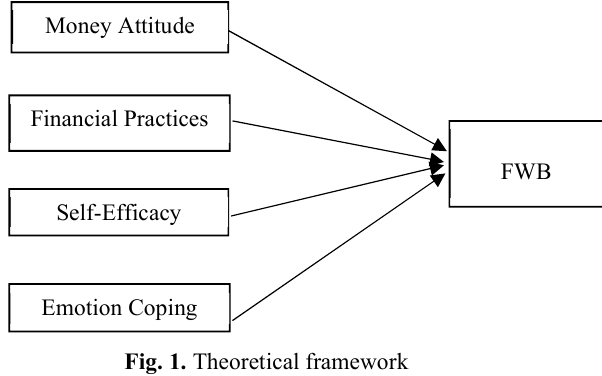
Fig. 1. Theoretical